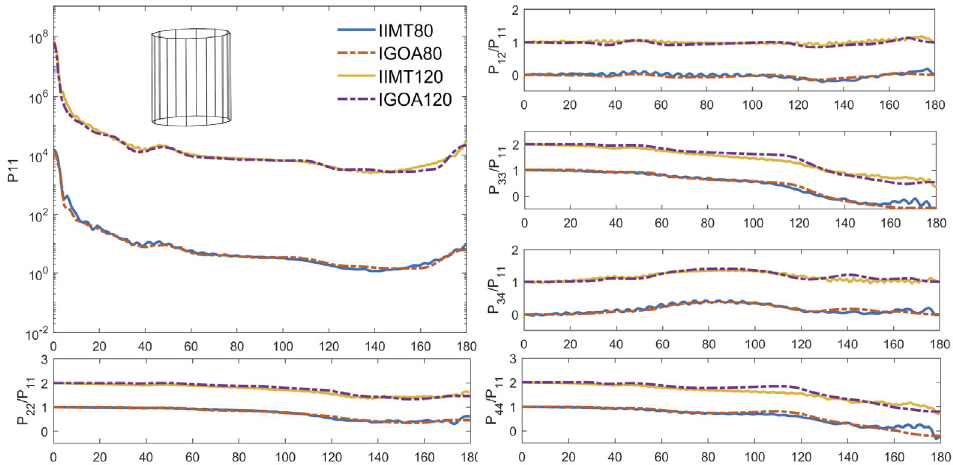
Figure 12. Comparison of four phase matrix elements computed from the IGOA and the II-TM for twelve prism particles. The particle size parameters for curve pairs from lower to upper are 80, 120. For clarity, the phase functions of 120 are multiplied by 1000, P 12 /P 11 , P 22 /P 11 , P 33 /P 11 , P 44 /P 11 and P 34 /P 11 of 120 are shifted by 1. The solid line is the IIM T-matrix model and the dashed is IGOA